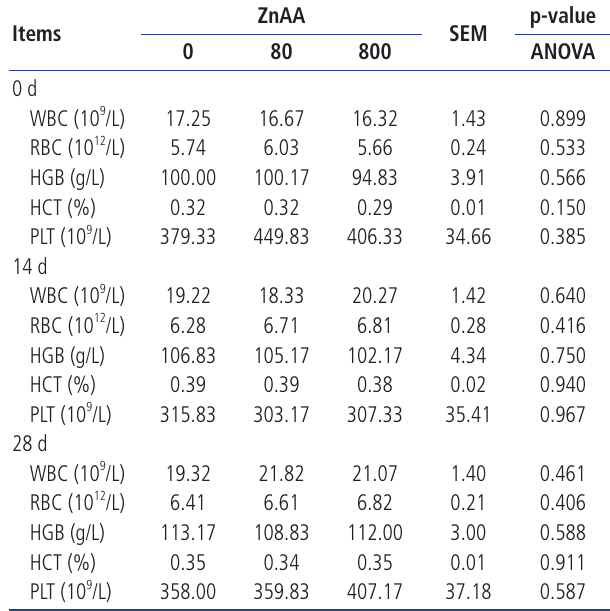
Table 5. Effects of zinc amino acid complex (ZnAA) on growth performance in weaned pigs 1) (Zn, mg/kg) Items